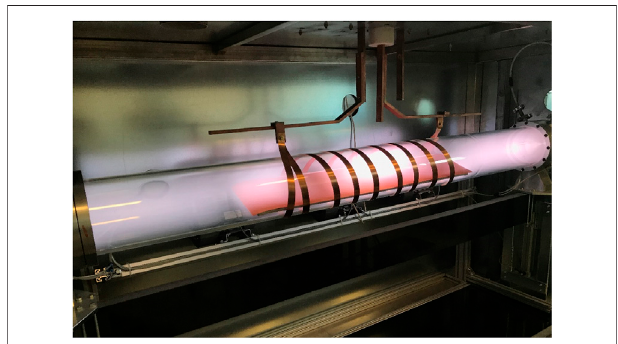
FIGURE 6 | A modern 2-m long plasma reactor powered with an inductively coupled RF discharge. Plasma is sustained in the air at the pressure of 20 Pa, and the discharge power of 3.5 kW.